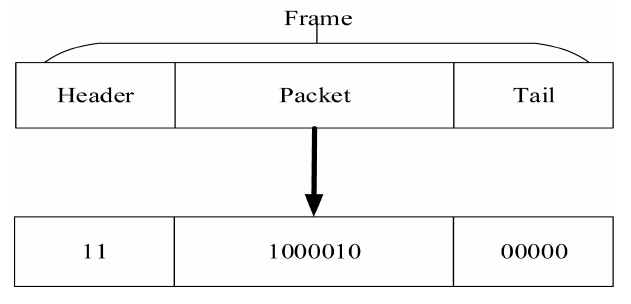
Table 2. The Experiment Parameters